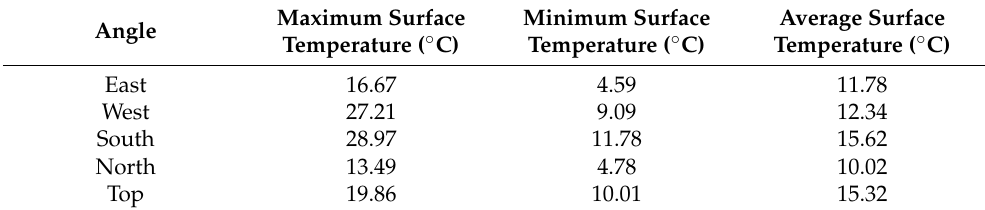
Table 7. The surface temperature of the black sphere at each angle ( ◦ C).